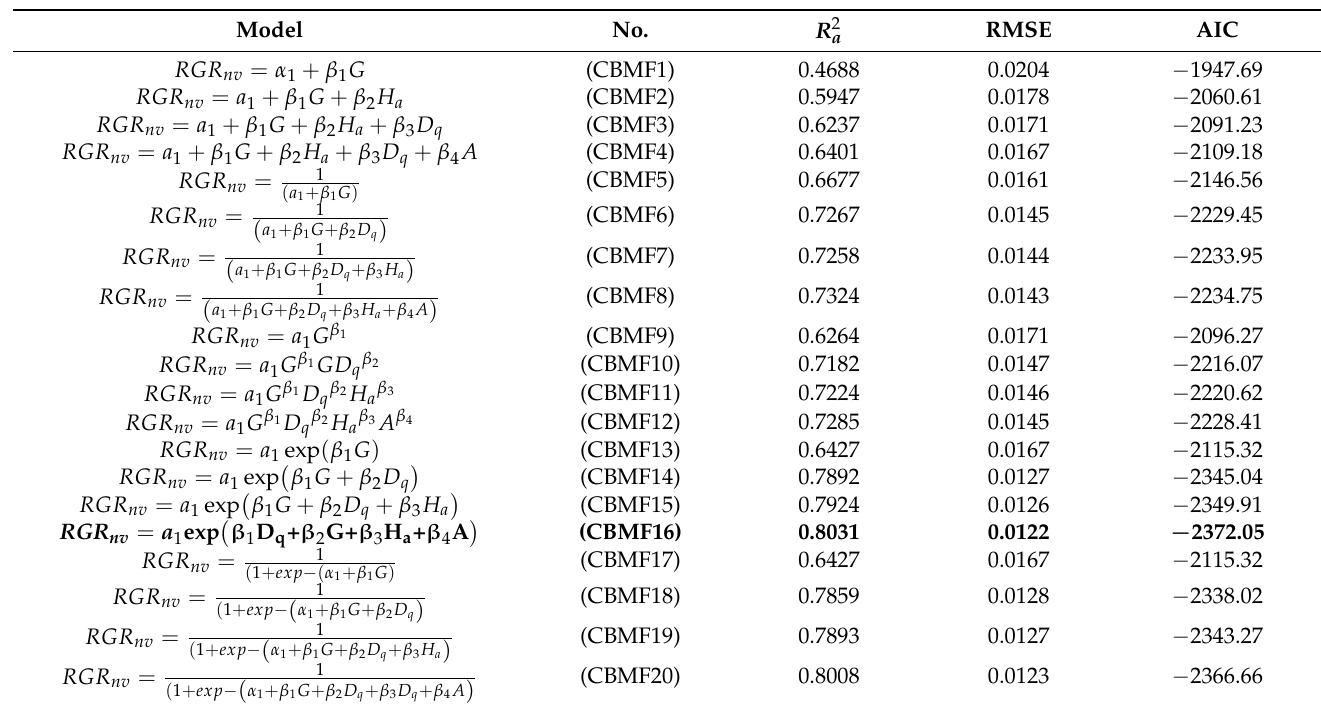
Table A3. Goodness-of-fit statistics of the basic RGR nv equations for mixed coniferous–broadleaf forest (CBMF).